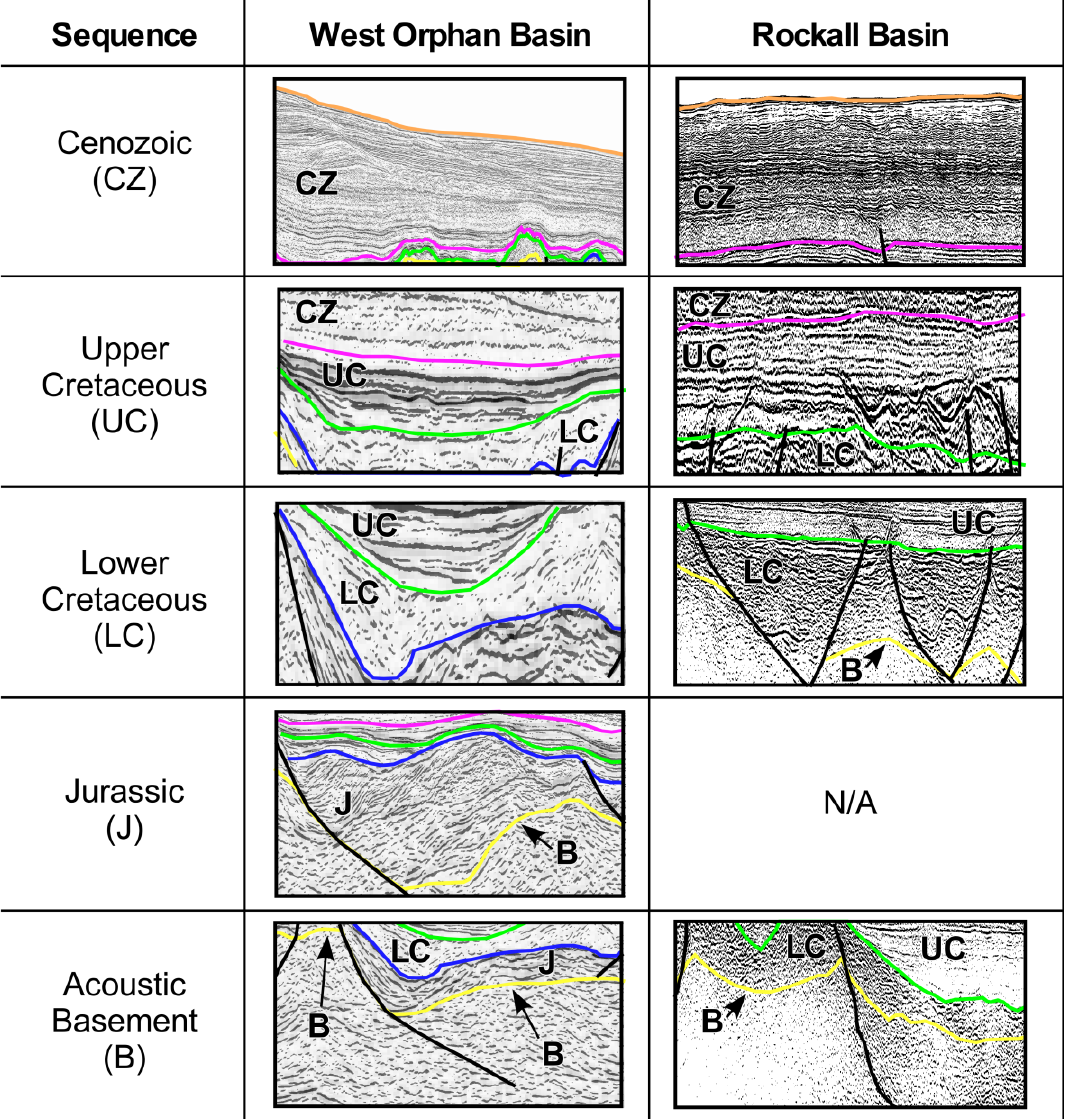
Figure 3. Examples from both the Rockall and West Orphan basins of individual lithological sequences defined on the basis of seismic character along lines NL1 ( middle column ) and IR1 ( right column ). Note: lack of division of the Cenozoic sequence as well as the lack of Jurassic sedimentary layers interpreted in the Rockall Basin.